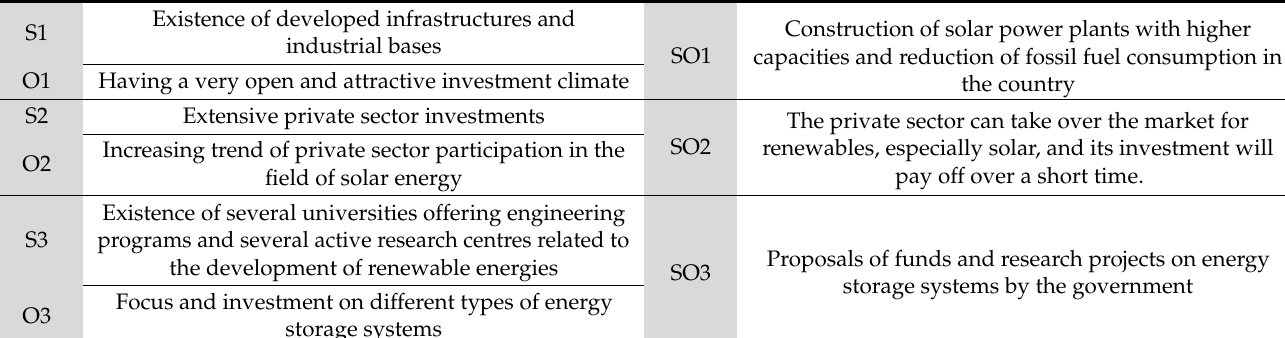
Table 1. SO array of the matrix.